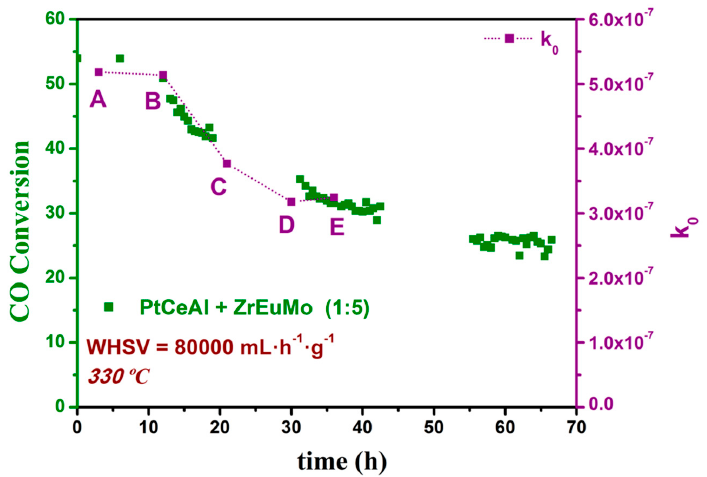
Figure 9. Decrease of the estimated preexponential factor ( k 0 ) of the reference tests of the structured sample compared to the stability of the same sample measured at 330 °C and 80,000 mL·h − 1 ·g cat − 1 with 9% CO, 30% H 2 O, 11% CO 2 and 50% H 2